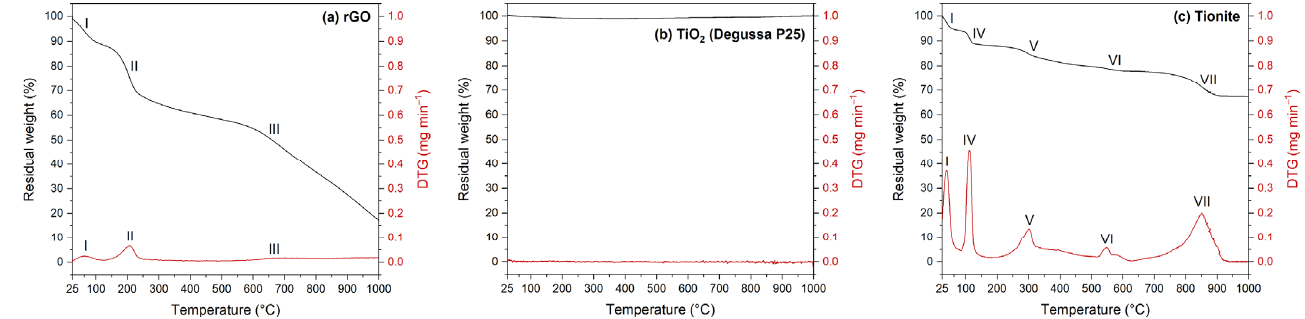
Figure 3. Thermogravimetric plots of ( a ) rGO, ( b ) Degussa P25 TiO 2 , and ( c )